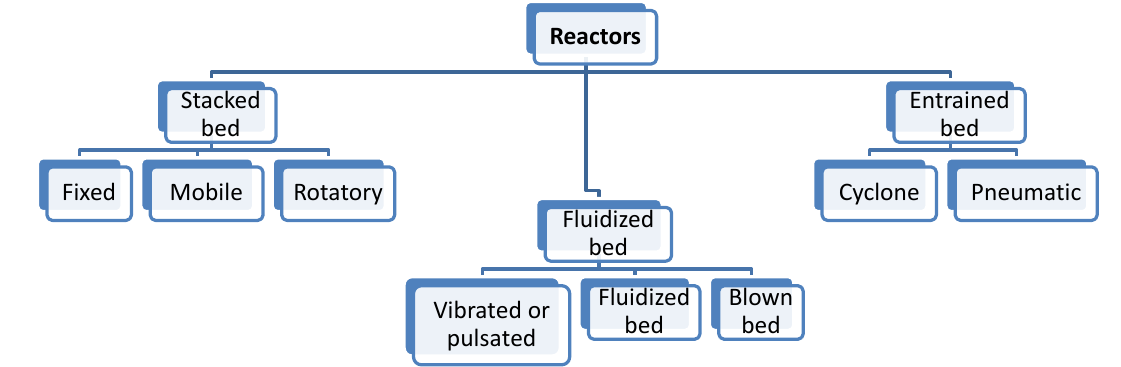
Figure 1. Classification according to the reactor type.